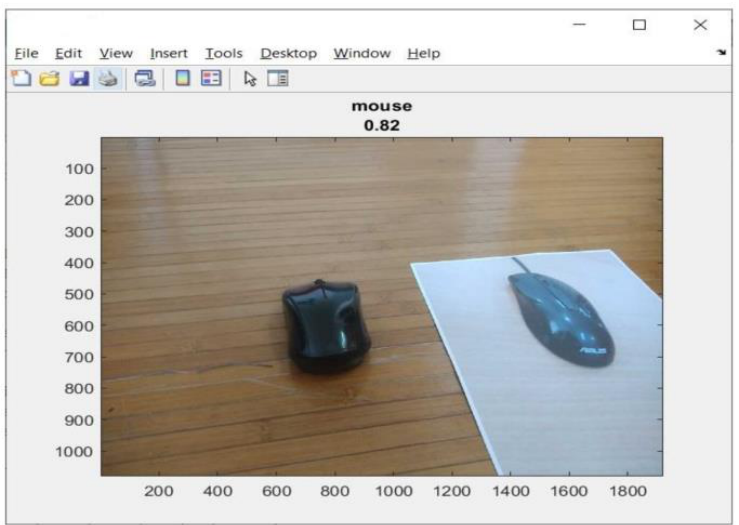
Figure 1. A sample detection object (mouse) in 2D and 3D.